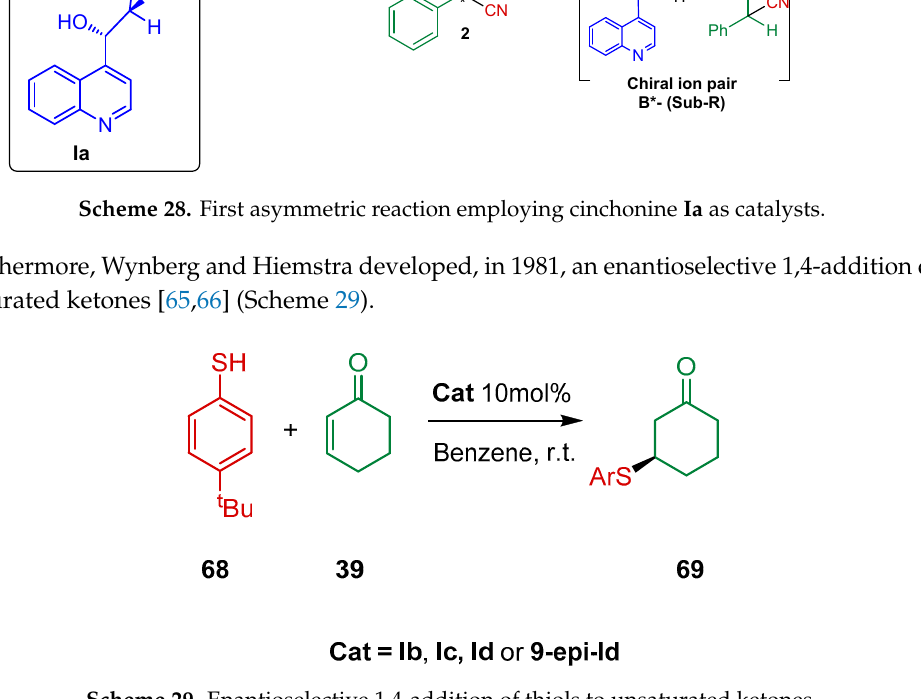
Figure 5. Cinchona alkaloids derivatives functionalized at the C9 position. 4.1. Synergistic Catalysis with Cinchona Alkaloids 4.1.1. Combination with Transition Metal-Based Catalysts A remarkable example of Cinchona -derived bifunctional catalysts in combination with metal- catalysts exploits copper(I) triflate to perform an asymmetric Conia-ene reaction of β -ketoesters 70 [69] (Scheme 30).